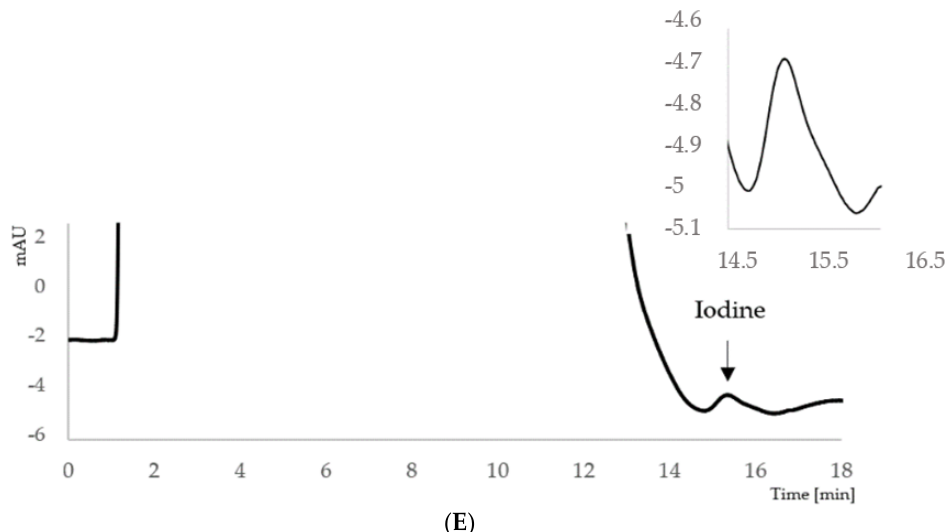
Figure 1. Representative chromatograms of ( A ) blank sample; ( B ) limit of detection (LOD); ( C ) limit of quantitation (LOQ); ( D ) calibration standard at concentration 200 µg/L; ( E ) urine sample of the pregnant woman (determined iodine concentration 271 µg/L). HPLC conditions: Pursuit XRs C8 column (250 × 4.0 mm, 5 µm); mobile phase: mixture of water phase (18–crown–6 ether, octylamine, sodium dihydrogen phosphate; pH 5.95) and acetonitrile (88:12, v / v ); UV detection at 225 nm.